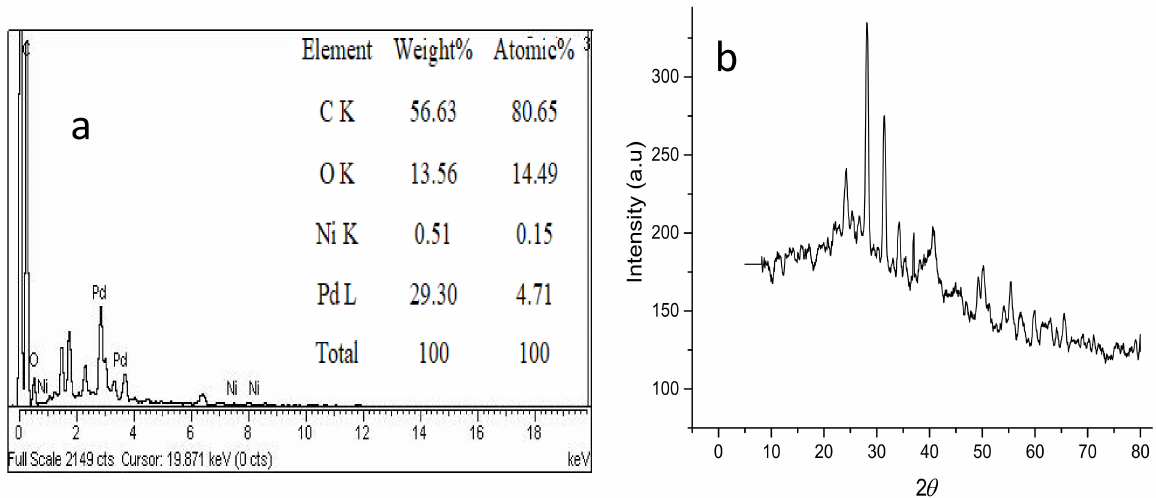
Figure 4. ( a ) EDX analysis; ( b ) X-rays Diffraction (XRD) spectrum of the